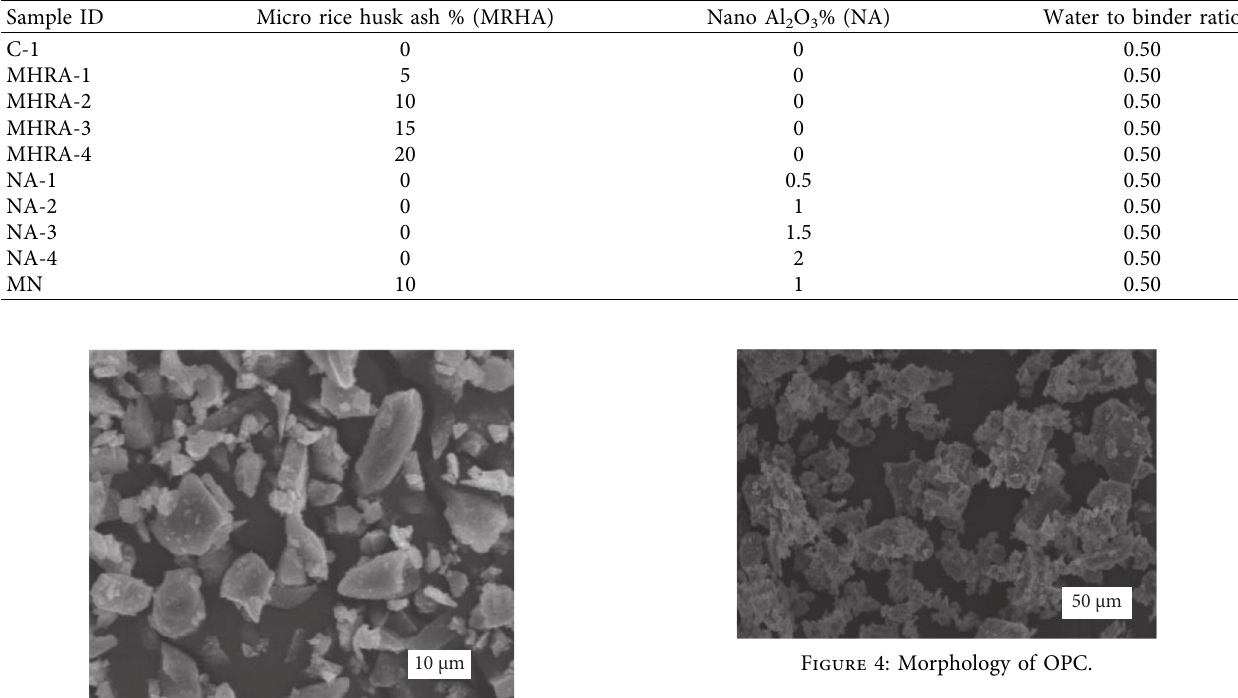
Figure 1: Morphology of micro MRHA.